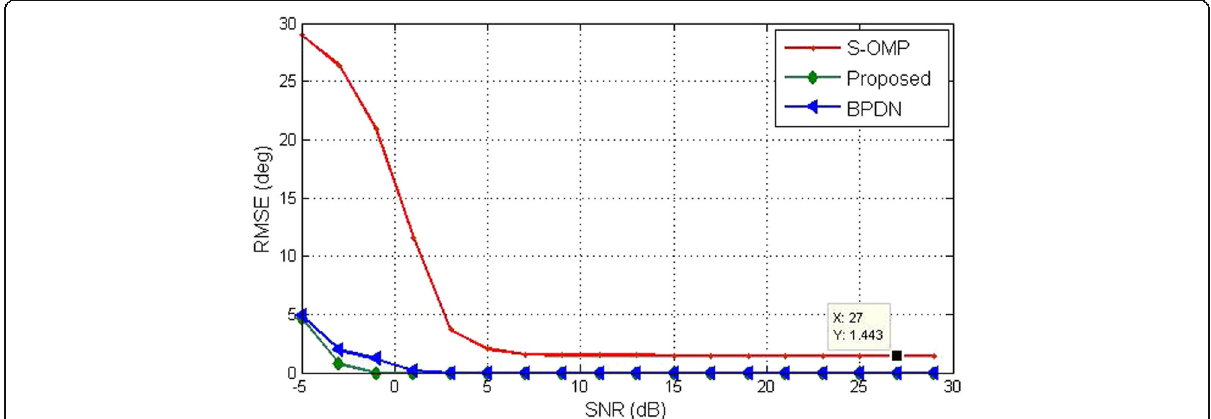
Fig. 8 Performance comparison of RMSE in LNA scenario for NLA 60,30